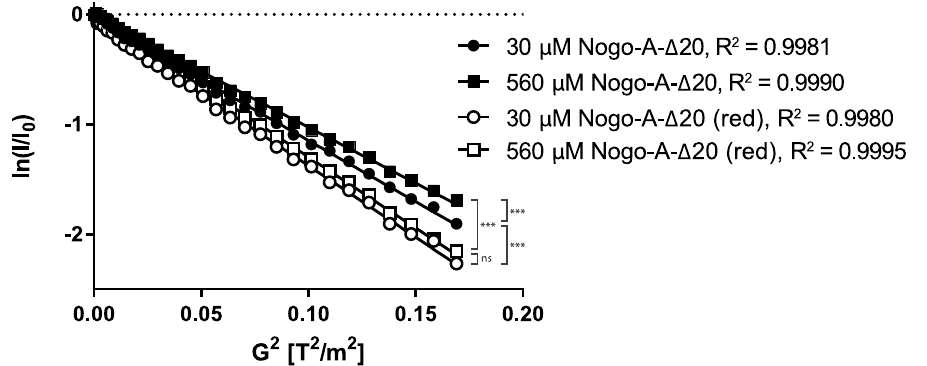
Fig 4. NMR diffusion experiments on Nogo-A- Δ 20. Logarithmicintensities of Nogo-A- Δ 20 at different conditions were plottedagainstits dependence on gradientstrength.Nogo-A- Δ 20 was measuredwith pulsed field gradientexperimentsat two concentrations (30 and 560 μ M),shown as closed circles and squares, respectively. The diffusioncoefficientwas calculatedaccordingto [36],resultingin D 30 μ M = 2.18 ± 0.02×10 -11 m 2 /s and D 560 μ M = 2.00 ± 0.01×10 -11 m 2 /s (mean ± SD). Nogo-A- Δ 20 was measuredagain in the presenceof the reducingagent TCEP, shown as open circles (30 μ M) and squares(560 μ M).Here, the diffusion